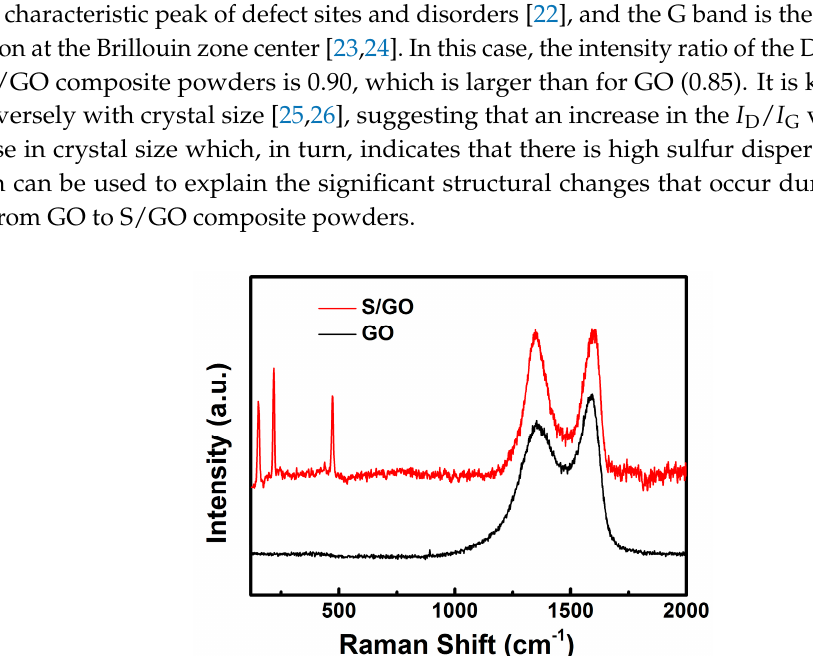
Figure 4. Raman spectra of GO and S/GO composite powders.